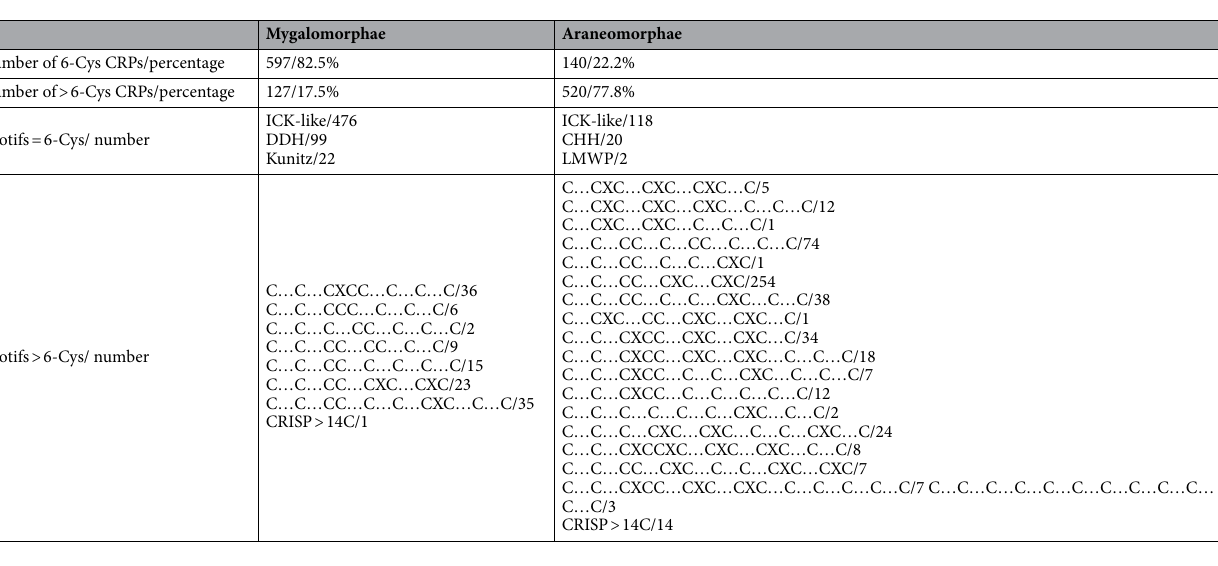
Table 3. Characteristics and distribution of common motifs of CRPs in Mygalomorphae and Araneomorphae. Capital letters indicate the corresponding amino acids. ‘C’ is cystine, and ‘X’ is any residue but cystine. The sequences are identified by deducing from Sanger sequencing and/or by Edman